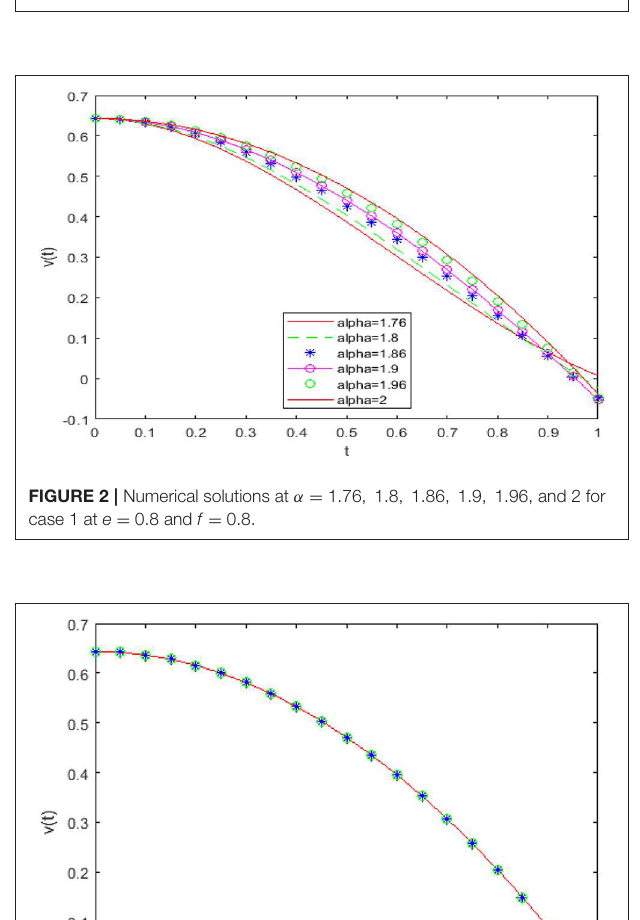
FIGURE 3 | Comparison of solutions at e